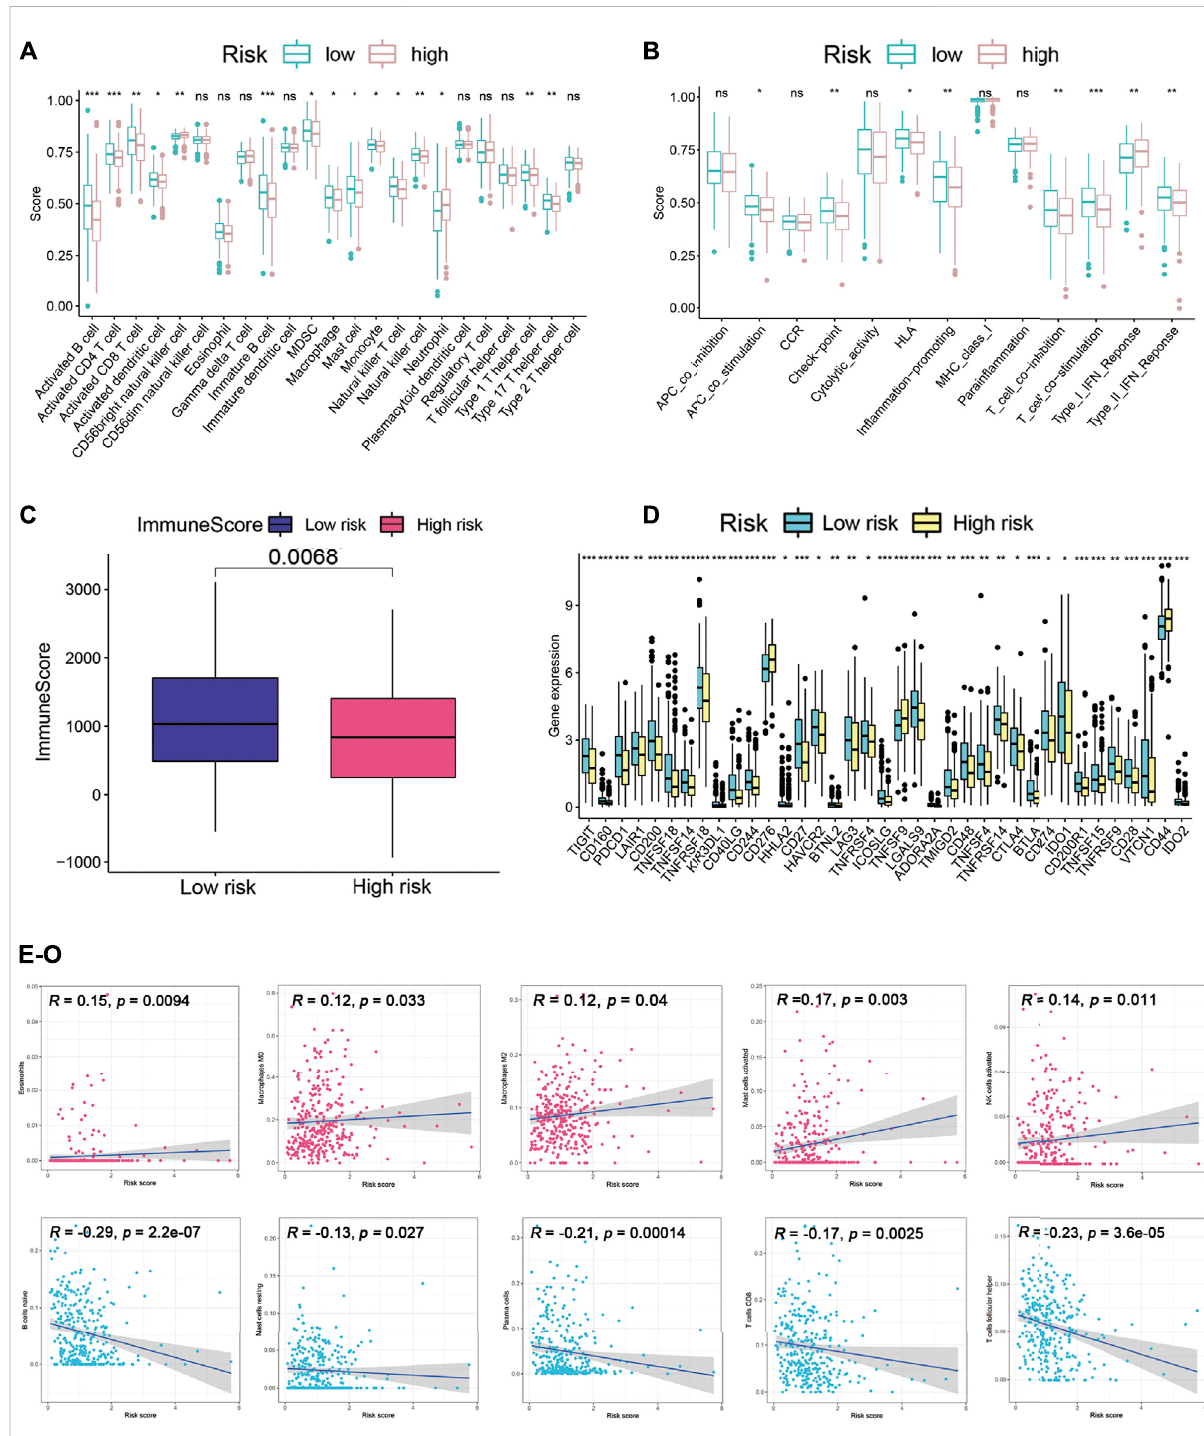
FIGURE 8 Immune landscape analysis. (A) Immune cellscoresbetweenhigh-riskandlow-riskgroups. (B) Immune functionscoresbetweenhigh-riskand low-risk groups. (C) Different immune scores between two risk subgroups. (D) Different expressions of immune checkpoints between high-risk and low-risk groups. (E – O) Association between the risk scores and diverse tumor lymph cells. * p < 0.05, ** p < 0.01, *** p <